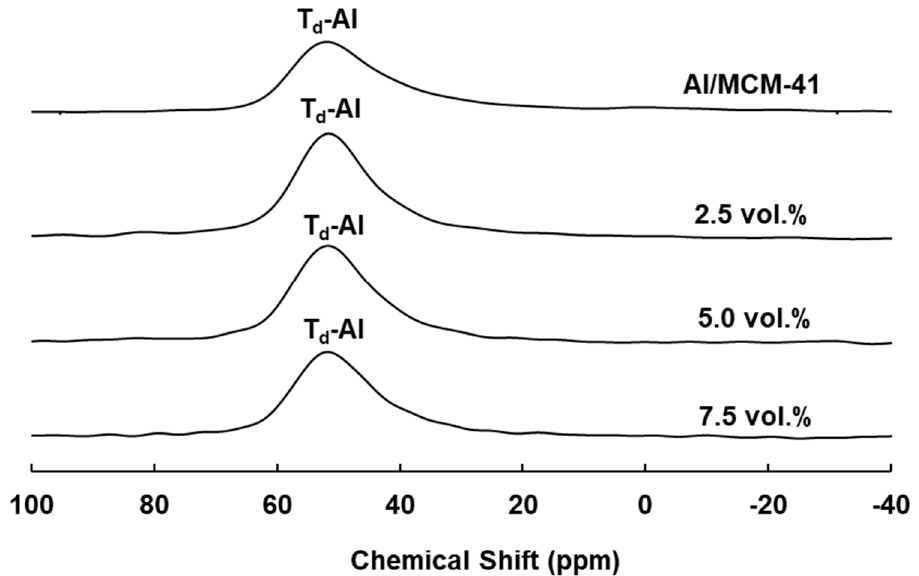
Figure 6. 27 Al NMR spectra of grafted NH 2 -Al/MCM-41 with different amine functional groups.